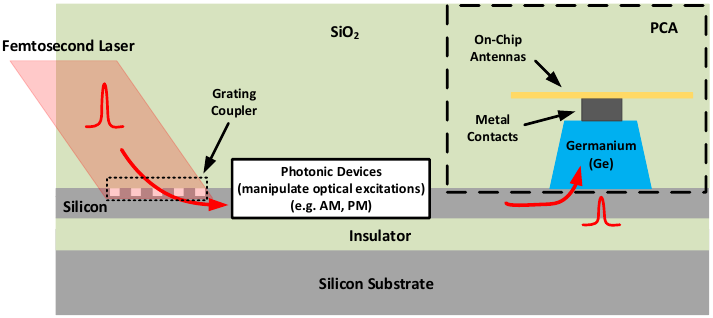
Figure 2. A conceptual illustration of the proposed optical waveguide coupling excitation